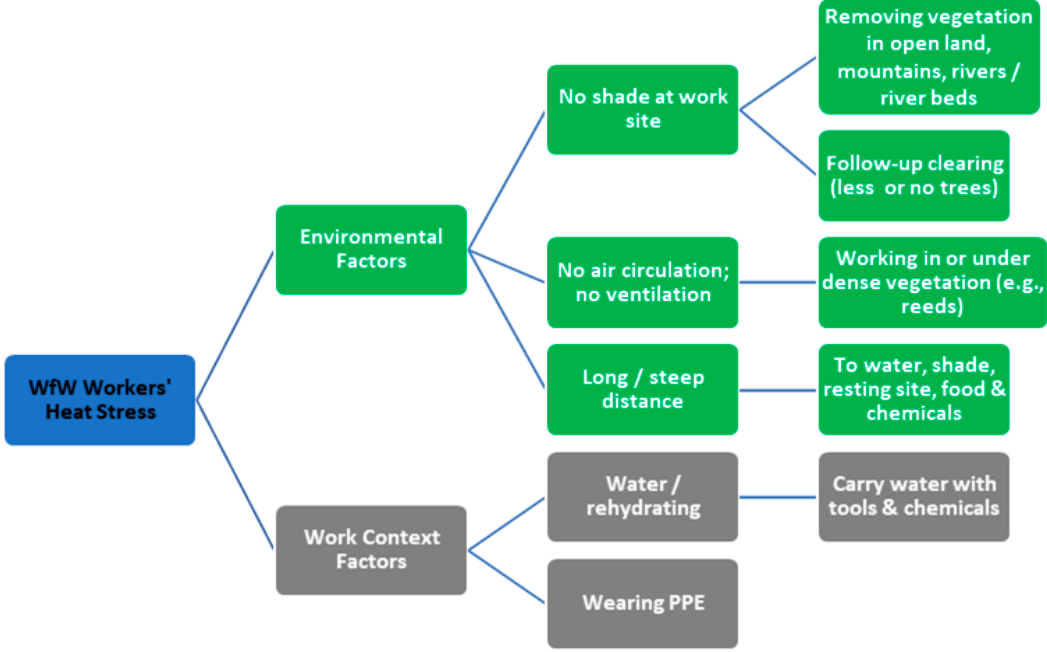
Figure 4. Heat stress exposure pathways participants identified through mapping.